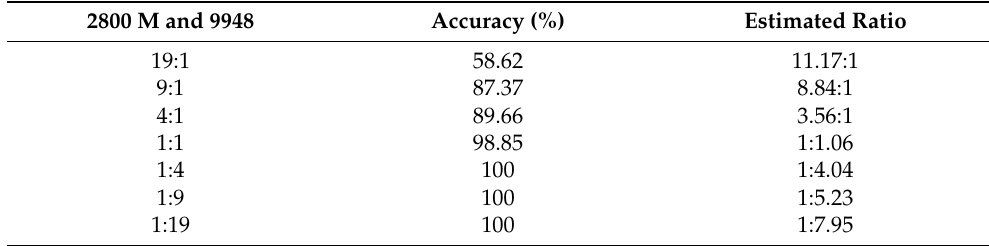
Table 3. The deconvolution accuracy of A-SNPs in 9948 and the estimated mixture ratio. 2800 M and